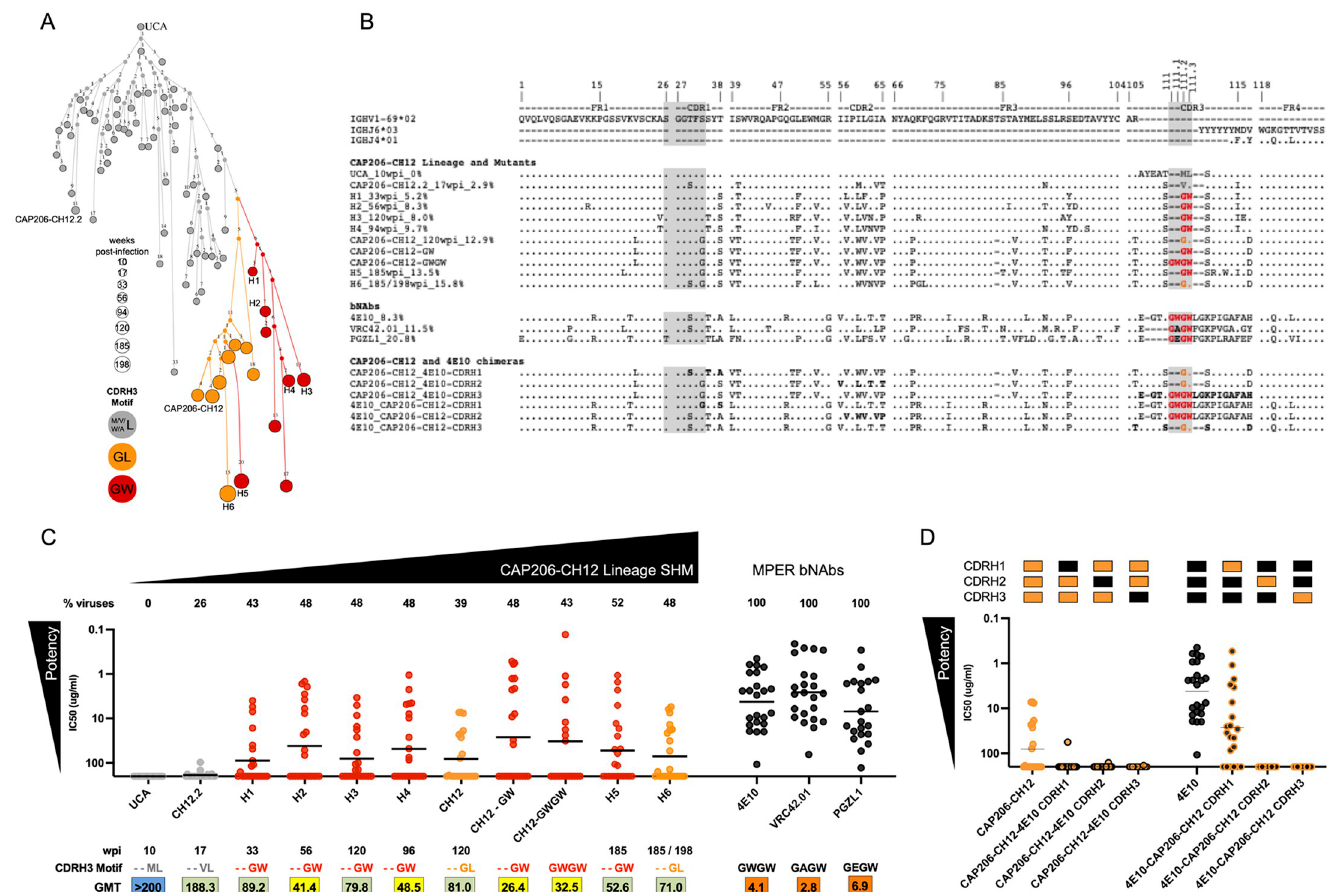
Fig 3. “ 111.2 GW 111.3 ” motif increases neutralization potency. (A) Reconstruction tree of the CAP206-CH12 clonally related heavy chain sequences coloured according to CDRH3 motif at positions 111.2 and 111.3. Those having a methionine, valine, tryptophan, or alanine (M/V/W/A 111.2 ) and leucine (L 111.3 ) are shown in grey, those with a glycine and leucine ( 111.2 GL 111.3 ) in orange, and those with a glycine and tryptophan ( 111.2 GW 111.3 ) in red. Small nodes present intermediate sequences inferred by Change-O, part of the immcantation portal, and clonally related sequences observed in the NGS data are represented by larger circles, sized according to time-point. Sequences selected for testing (UCA, H1 –H6, CAP206-CH12.2, and CAP206-CH12) are labeled. (B) Heavy chain sequences of the UCA, CAP206-CH12.2, H1 –H6, CAP206-CH12, 4E10, VRC42.01, PGZL1, mutated (CAP206-CH12-GW and CAP206-CH12-GWGW) and chimeric antibodies (CAP206-CH12/4E10 CDRH swaps) compared to the shared germline IGHV1-69 and IGHJ6 ( IGHJ4 used by VRC42.01, PGZL1 and 4E10). CDRH1 and CDRH3 regions important for 4E10 and VRC42.01 binding are highlighted in grey. Within the CDRH3, amino acids are coloured according to the motif as shown for (C). Sequences are numbered according to the IMGT numbering system (www.imgt.org). (C) Neutralization of CAP206-CH12 lineage mAbs (coloured according to the 111.2 GL 111.3 or 111.2 GW 111.3 motif as seen in panels A and B) and MPER bNAbs (VRC42.01, PGZL1 and 4E10) against a panel of 23 viruses (neutralized by CAP206 plasma). The black line for each mAb represents the geometric mean titre. The percentage of viruses (out of a panel of 23 viruses that were neutralized by CAP206 donor plasma [23]) neutralized are shown above each mAb. The time-point at which each heavy chain sequence was observed or mAb was isolated, CDRH3 motif, and geometric mean titre are given below each mAb. ( D ) Neutralization of CAP206-CH12 and 4E10 CDRH chimeras compared to CAP206-CH12 and 4E10 wild-type. Shown are the IC 50 titres with the line representing the geometric mean. Coloured blocks above each mAb are coloured by mAb for each region, with CAP206-CH12 in orange and 4E10 in black.